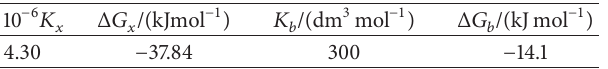
Table 3: The data of partition coefficient ( 𝐾 𝑥 ), free energy of partition ( Δ𝐺 𝑥 ), binding constant ( 𝐾 𝑏 ), and the free energy of binding ( Δ𝐺 𝑏 ) for reactive orange 122/CTAB system.